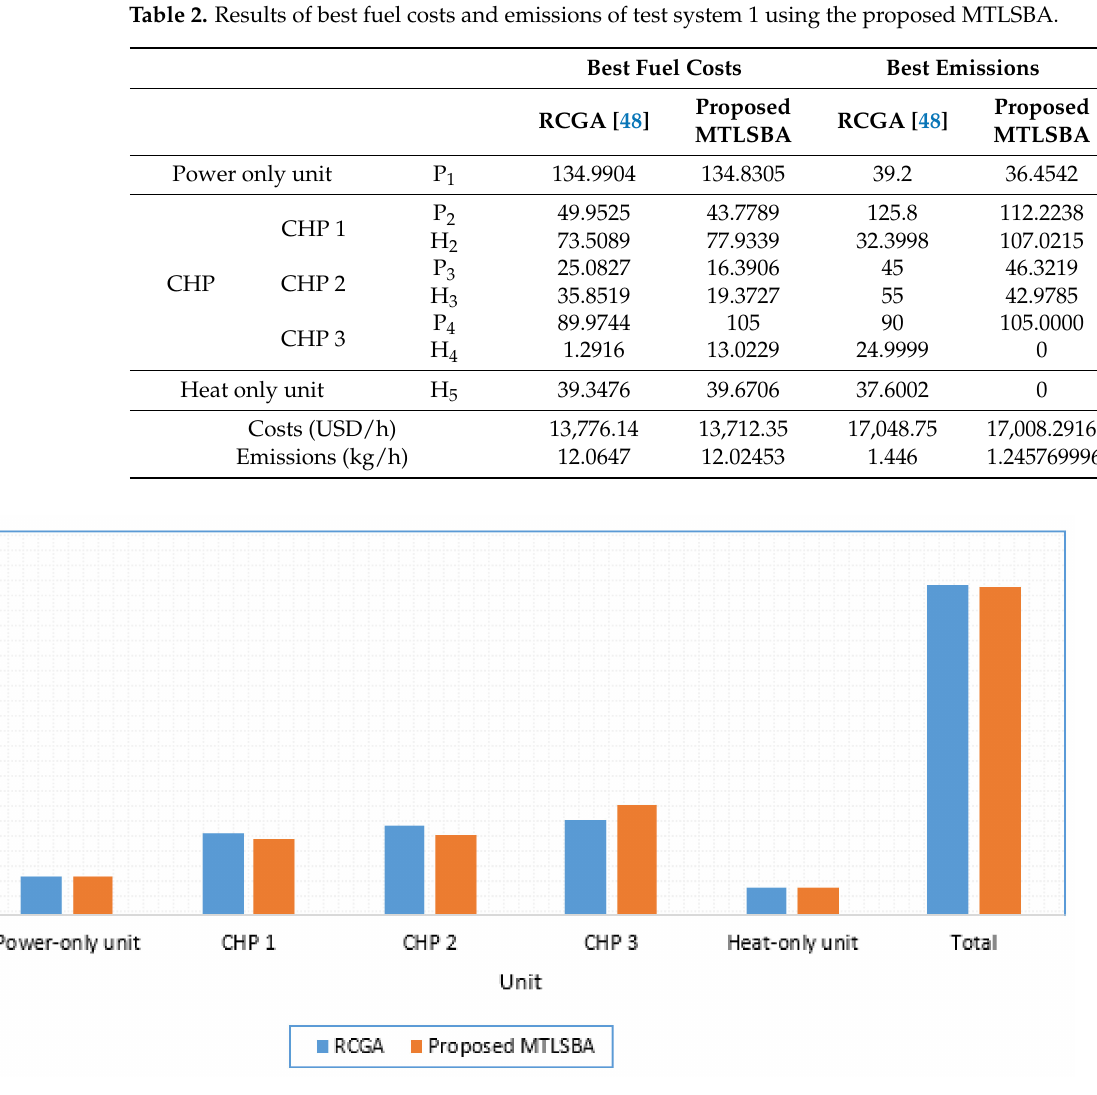
Figure 5. Fuel costs for each unit related to the best fuel costs in Table 2.